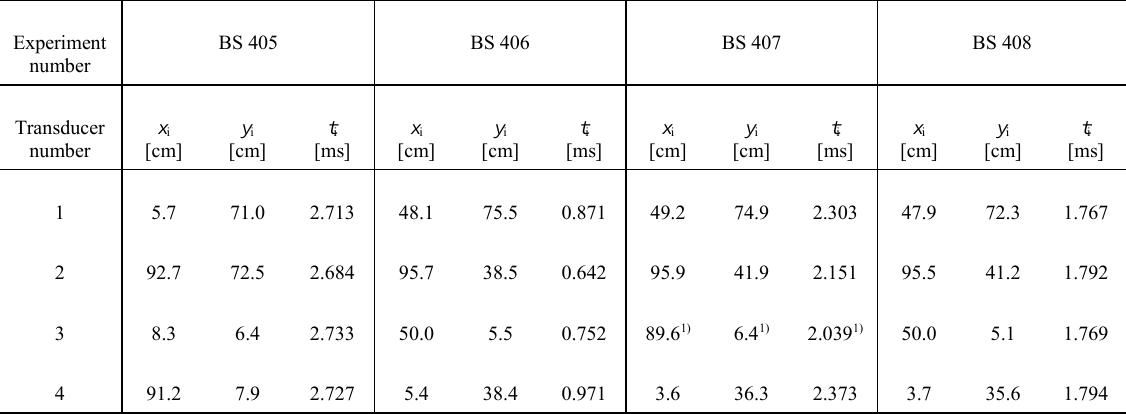
Table 4: Summary of coordinates of transducer positions and arrival time of the shock wave of initial cracking (BS 405 to BS 408). Coordinate origin is the lower left corner of the pane. Experiment number